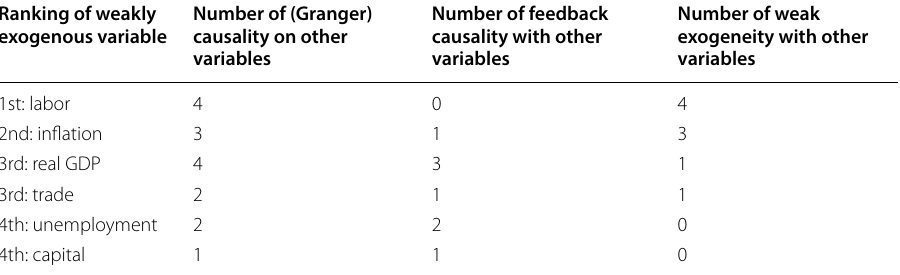
Table 5 Ranking of weak exogeneity Ranking of weakly exogenous